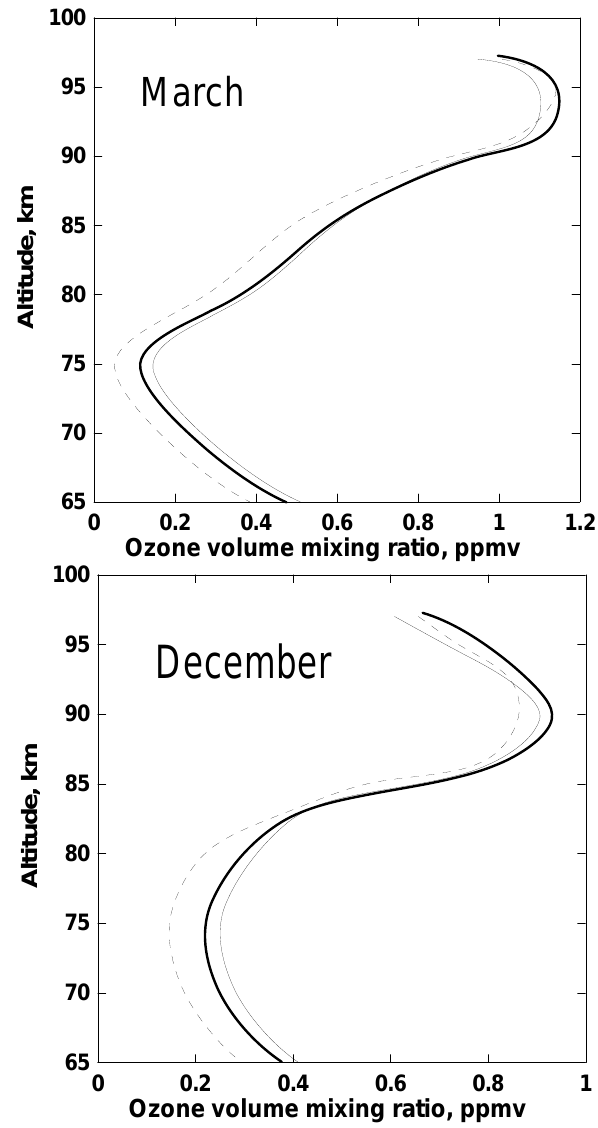
Fig. 9. Altitude profiles of ozone concentration retrieved from “measured” O 2 emissions at 762nm (thin solid line) and 1.27 µ m (dashed line) in accordance with pure electronic kinetics model. “Measured” volume emission rates at 762nm and 1.27 µ m were calculated in accordance with electronic-vibrational kinetics model at using HRDI ozone profiles for March and December (thick solid line) (Marsh et al.,